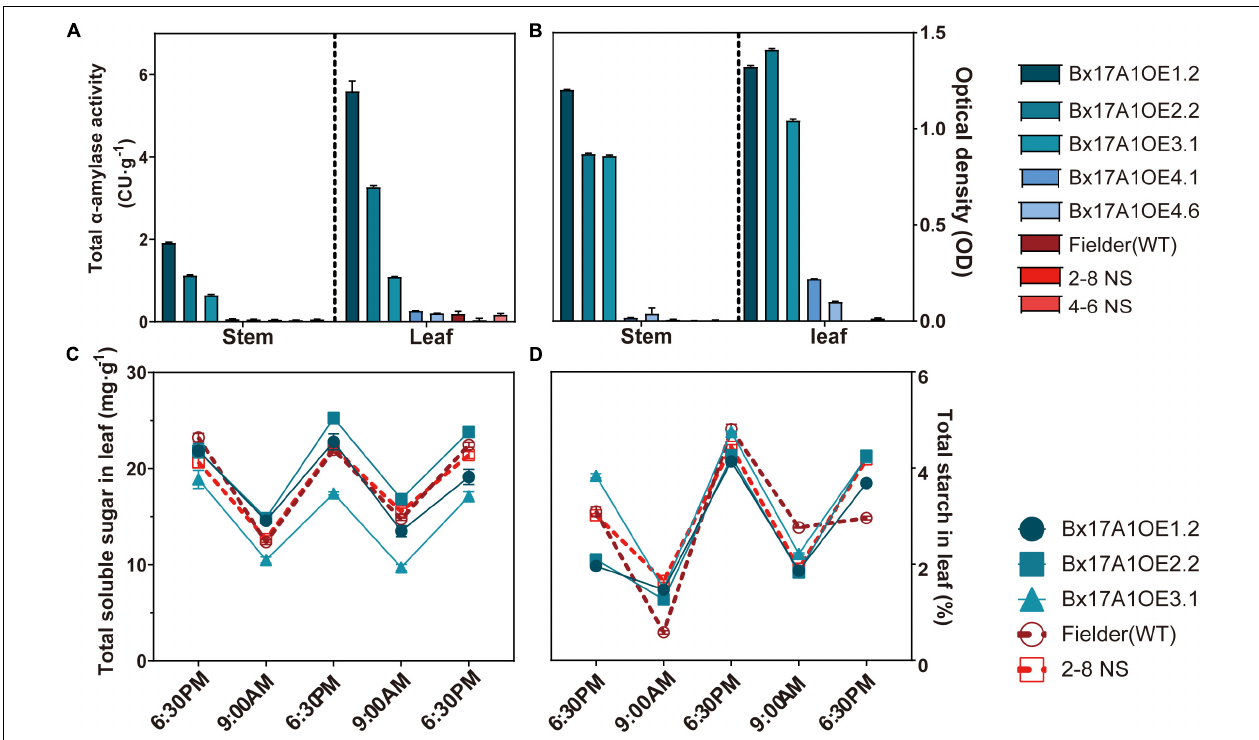
FIGURE 2 | Effect of TaAMY1 overexpression on stem and leaf sugar composition. Total α -amylase activity (A) and TaAMY1 protein content expressed by optical density (B) in stem and leaf. Total soluble sugar (C) and total starch (D) from dry leaf at sunrise and sunset for three consecutive days. Three technical replicates were performed with SE